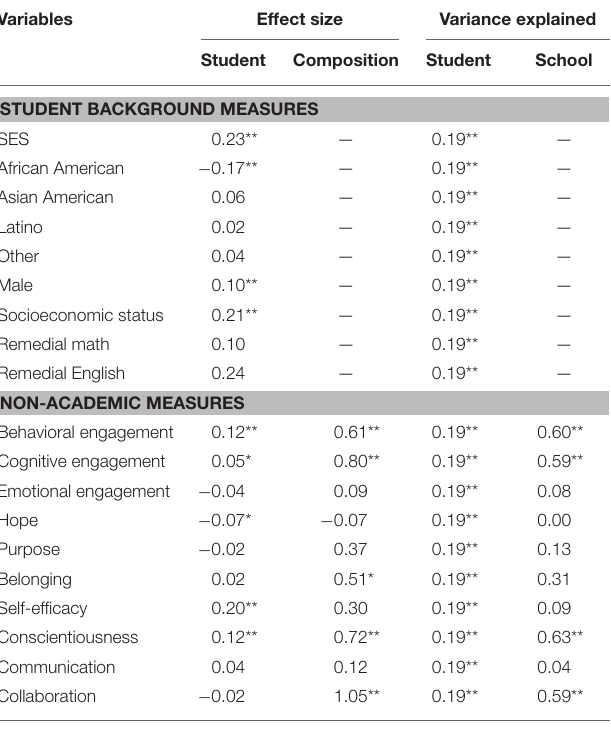
TABLE 6 | Student and peer composition effects on academic performance, controlling for student demographics and all other non-academic variables.